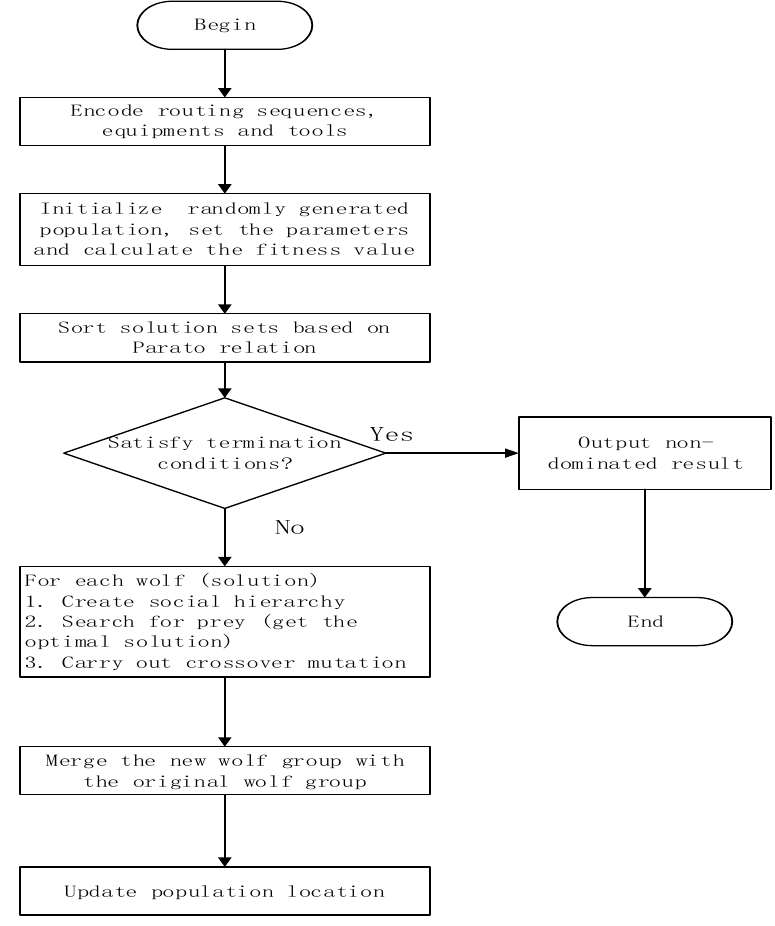
Figure 3. The flow of Grey Wolf Optimizer.